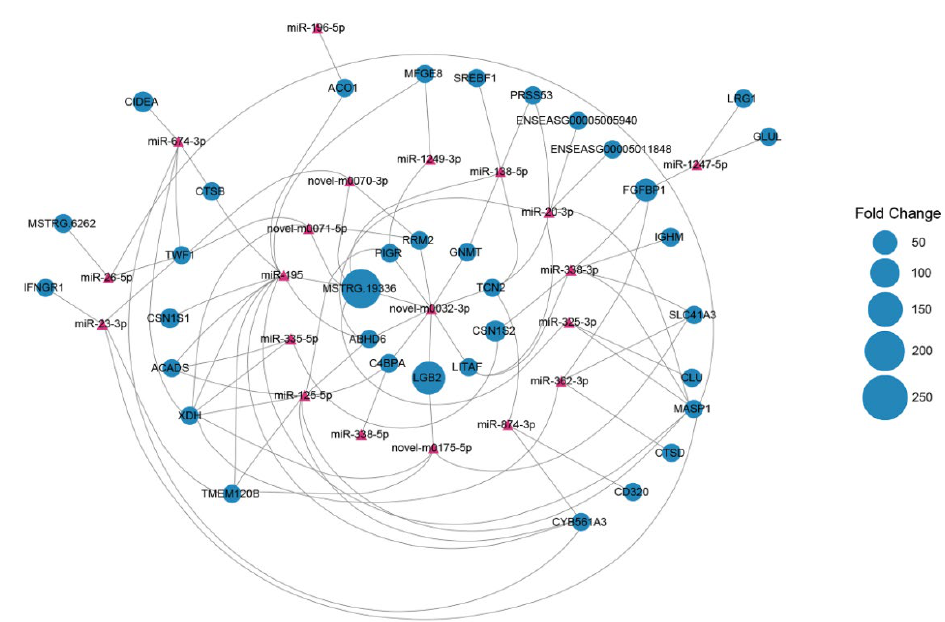
Figure 6. Integrated miRNA-target negative correlation regulatory network. The differentially expressed miRNAs are displayed as red triangles, and the target mRNAs are shown as blue circles. The sizes of blue circles indicate the fold changes in the lactating period compared to the nonlactating period.